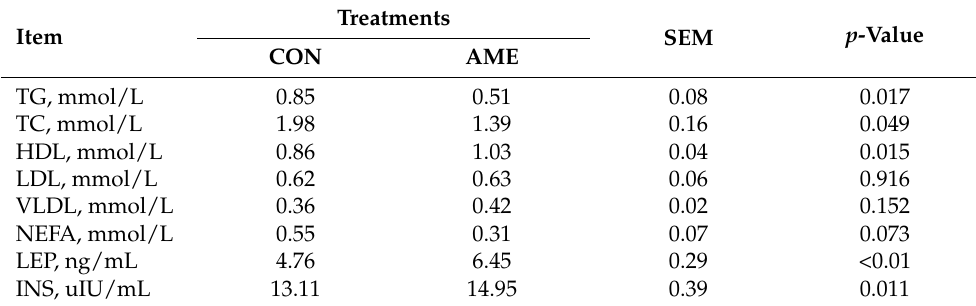
Table 2. Effect of AME on the serum index of lambs.